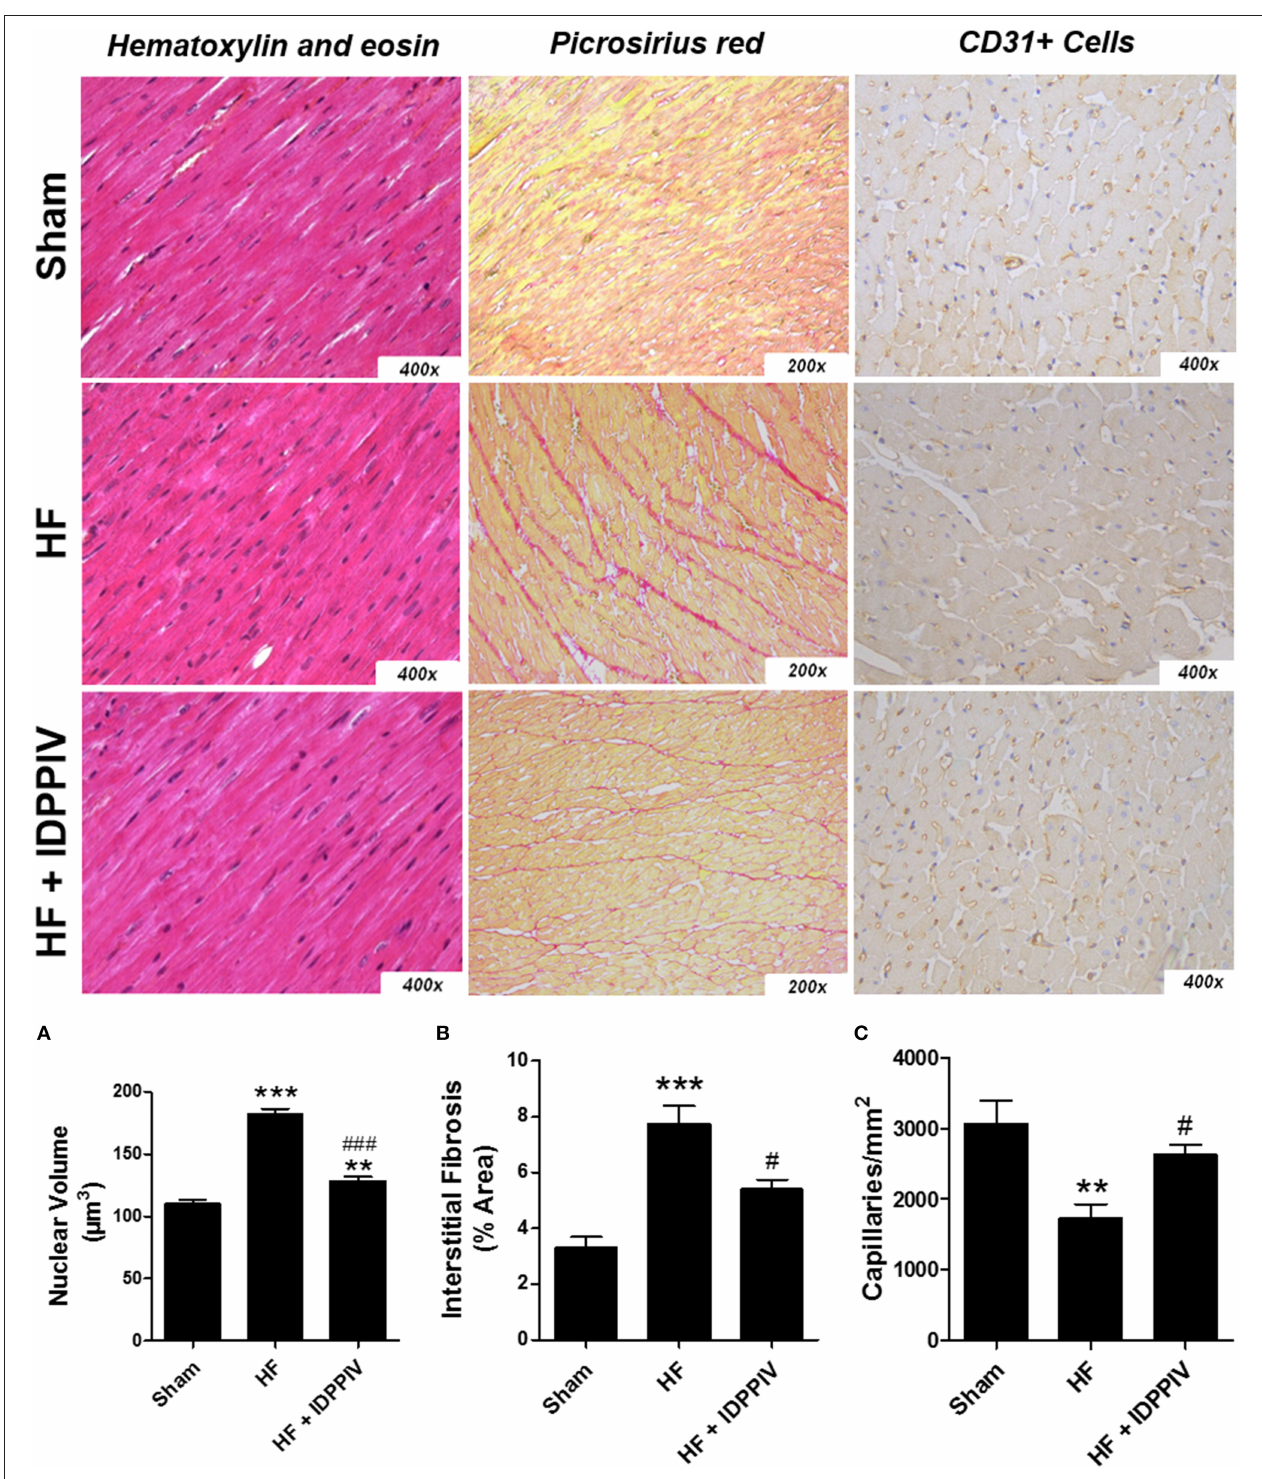
FIGURE 2 | DPPIV inhibition attenuates cardiac remodeling and capillary rarefaction in rats with established HF. (A) Myocardial hypertrophy was assessed in HF rats treated with vehicle (HF) or vildagliptin (HF + IDPPIV) by measuring cardiomyocyte nuclear volumes in heart sections treated with stained with hematoxylin-eosin (400 × original magnification). (B) Cardiac interstitial fibrosis was evaluated in heart sections stained with picrosirius red (200 × original magnification). (C) Representative immunohistochemical staining of CD31 in sections of the LV viable wall showing individual capillaries (small dark circles) (400 × original magnification). n = 7–9 rats/group. Values are means ± SEM. ** p < 0.01 and *** p < 0.001 vs. Sham. # p < 0.05 and ### p < 0.001 vs. HF.